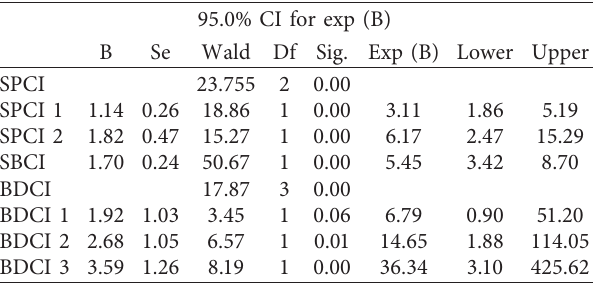
Table 10: The variables in the equation and parameter estimates.